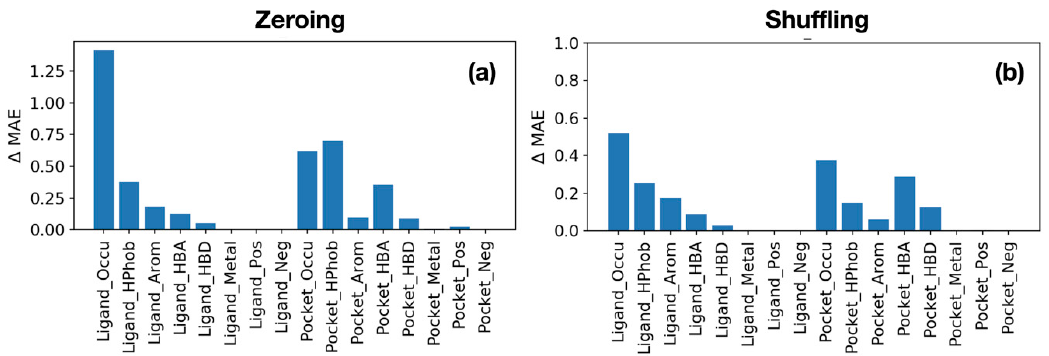
Figure 7. Feature importance calculation results measured by the loss of prediction accuracy, the increase of mean absolute error of predictions in kcal/mol (Y-axis). ( a ) A channel corresponding to a feature (X-axis) is filled with zero. ( b ) The values of a channel corresponding to a feature are randomly shuffled.